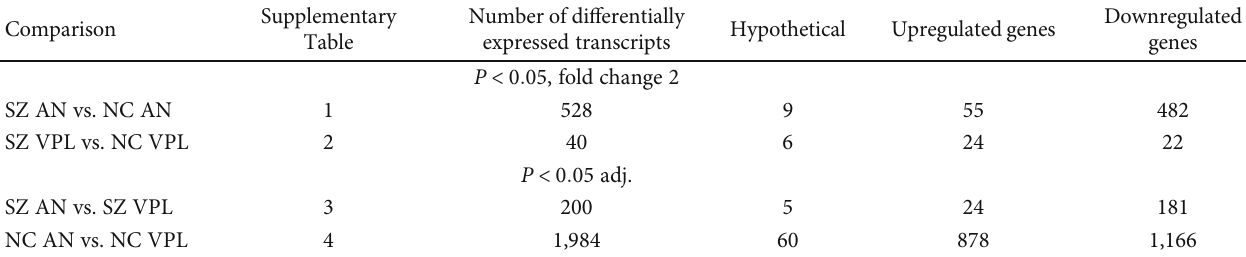
Table 2: Summary of transcripts showing di ff erential expression in each